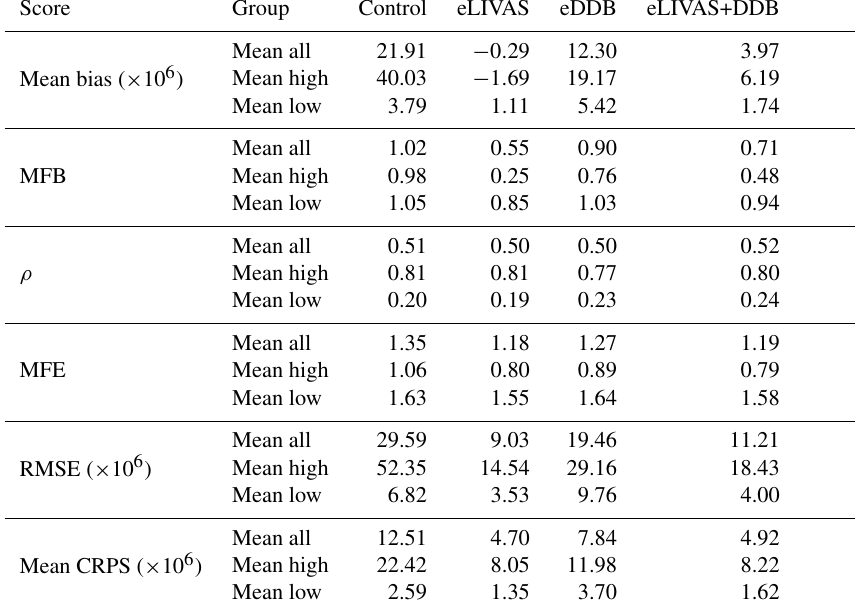
Table 2. Values of the last three columns of Fig.